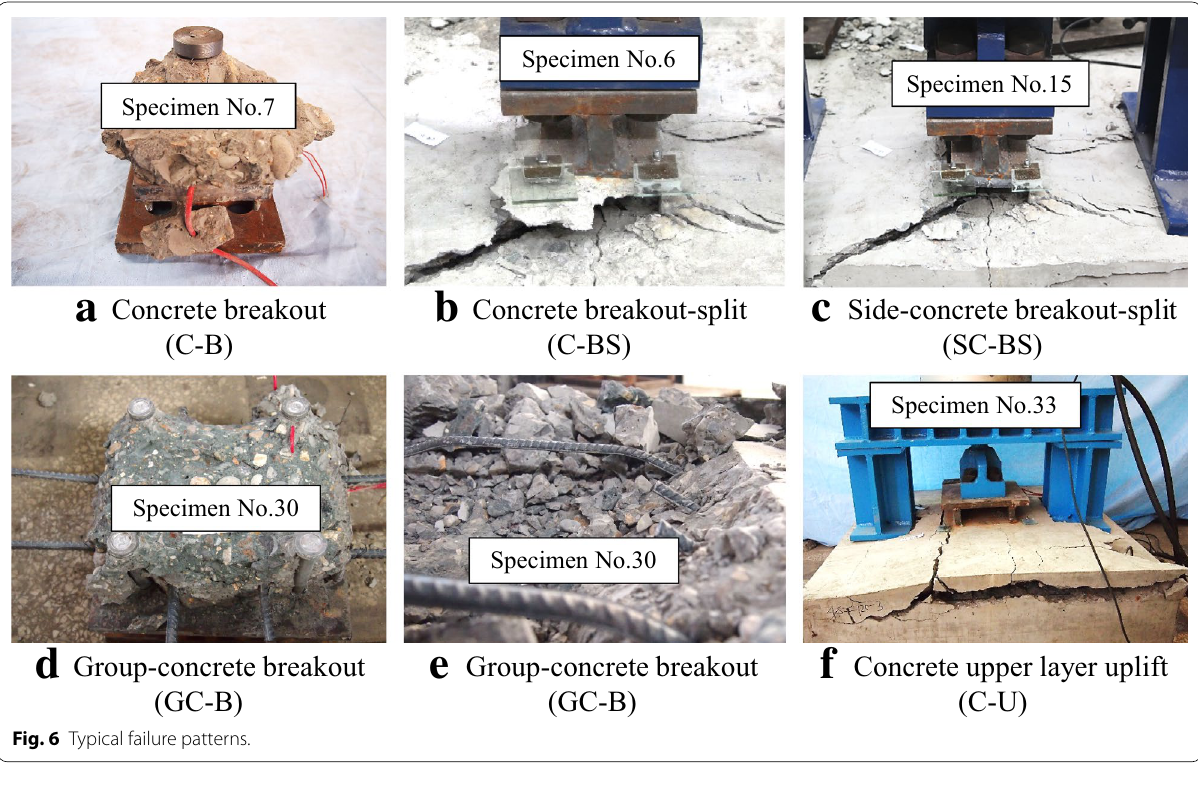
Fig. 6 Typical failure patterns.